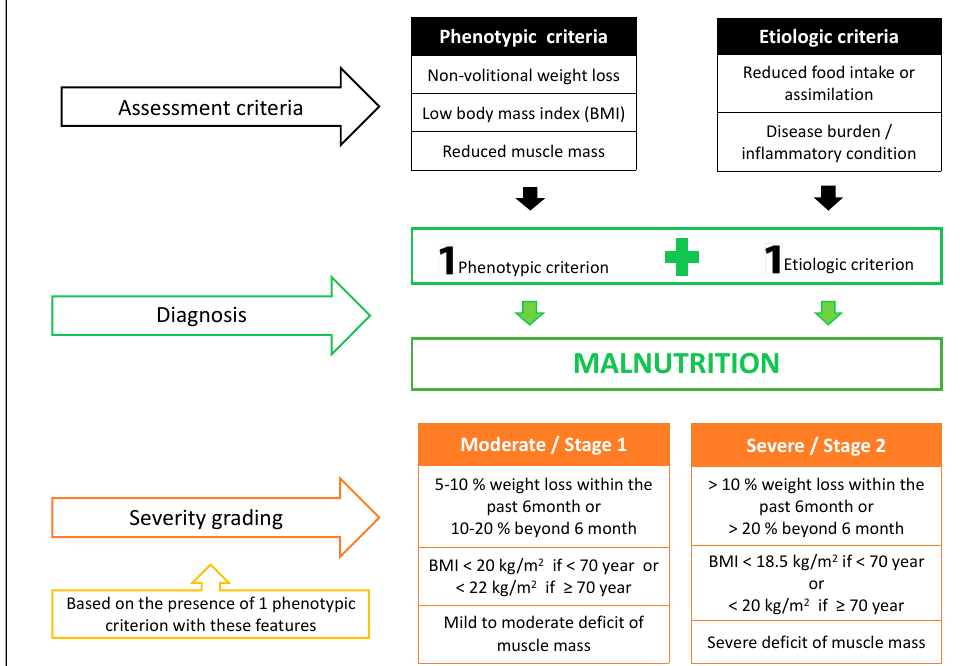
Figure 2. The Global Leadership Initiative on Malnutrition (GLIM) criteria of malnutrition diagnosis and severity grading [36].